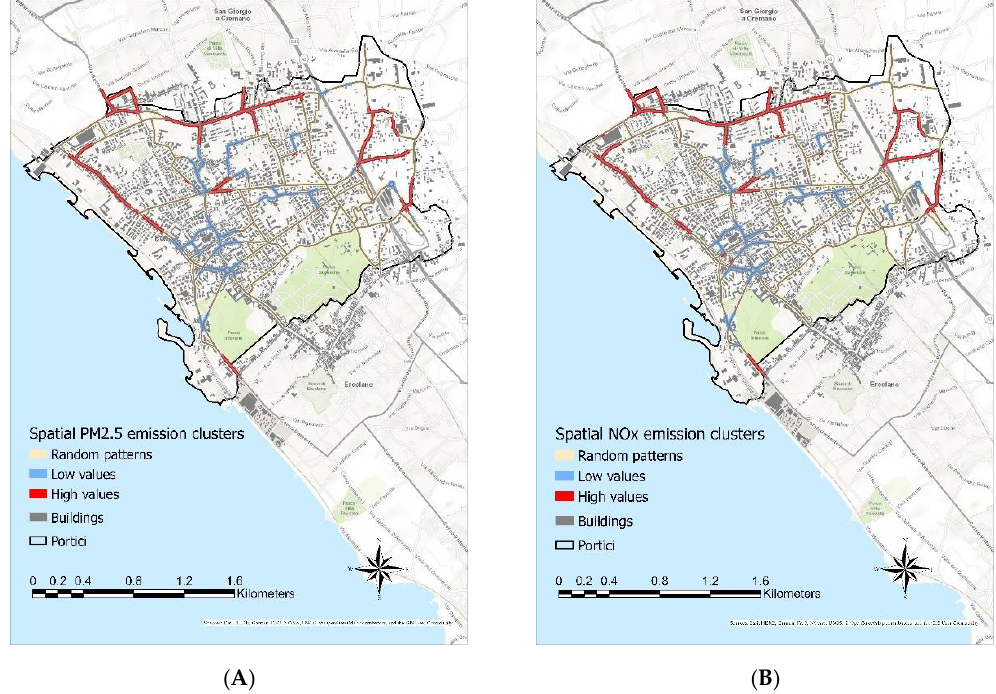
Figure 7. Traffic emission zoning maps of the urban road network obtained by the Hot Spot analysis of pollutants emission values referred to ante-meridian hours of a typical workday of October. ( A ) Map of PM 2.5 emission values clusters and ( B ) Map of NOx emission values clusters